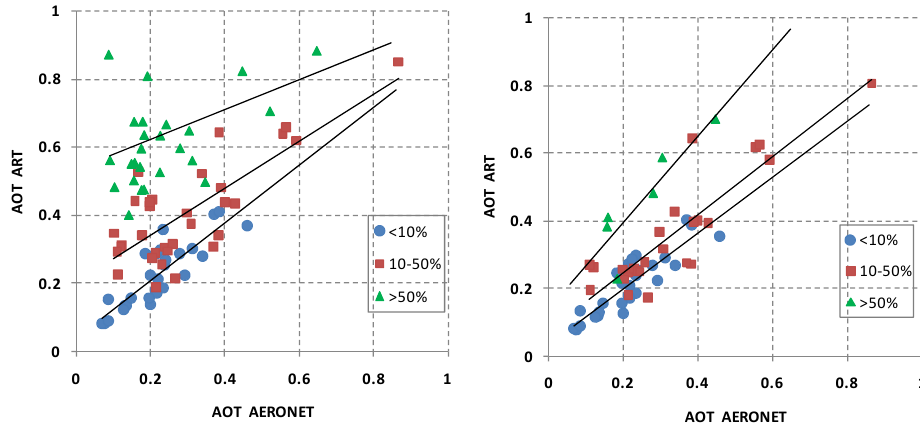
Fig. 25. The same as in Fig. 24, except for the region of Zvenigorod (Russia).